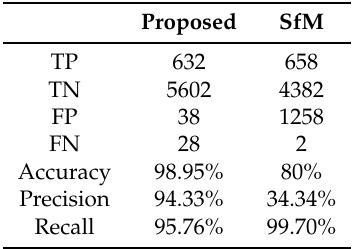
Table 3. Performance of road surface defects detection for different